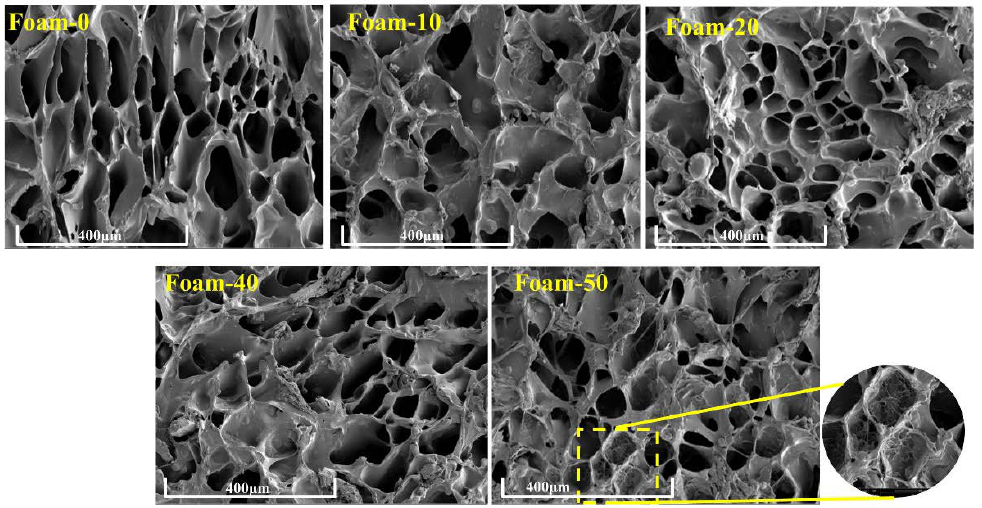
Figure 2. SEM images of different composite foams.